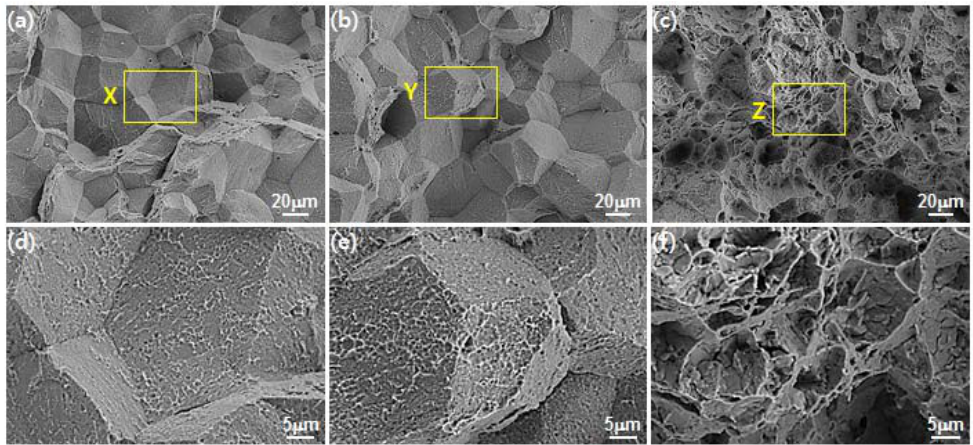
Figure 3. Representative SEM photomicrographs of the fracture surfaces of specimens that failed during testing at ( a ) 650 °C, ( b ) 700 °C, and ( c ) 750 °C. Enlarged SEM photomicrographs ( d – f ) at regions denoted by X, Y, and Z.